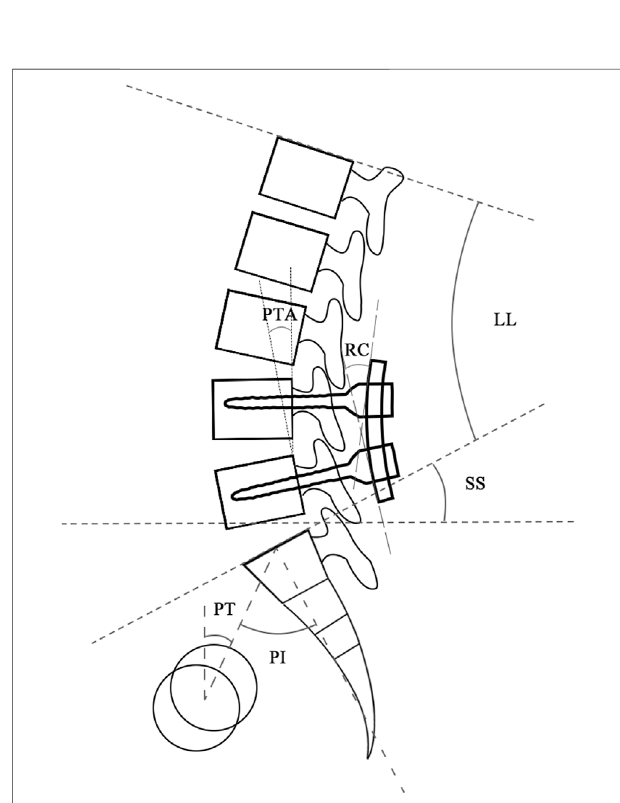
FIGURE 3 | Radiographic parameters measured from lateral radiographs. Abbreviation: LL, lumbar lordosis; PT, pelvic tilt; PI, pelvic incidence; SS, sacral slope; RC, rod curvature; PTA, posterior tangent angle of fused segments.